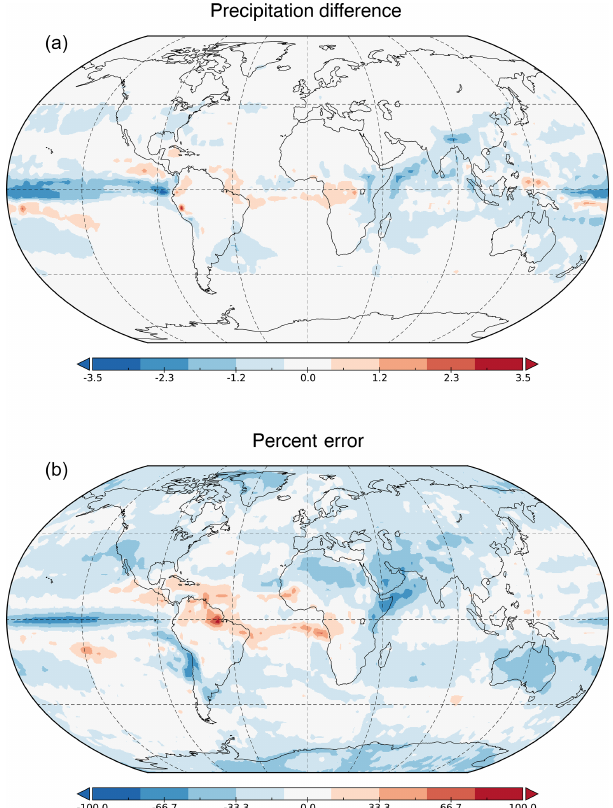
Figure 2. Precipitation outcomes (mm d − 1 ) for the period 1969– 1989. Top shows the average output of the CanESM2 over that pe- riod. Bottom shows the average output of a 252-month forecast over the same time period using the 18-layer residual network with a window size of 60. Both models show qualitatively similar features.